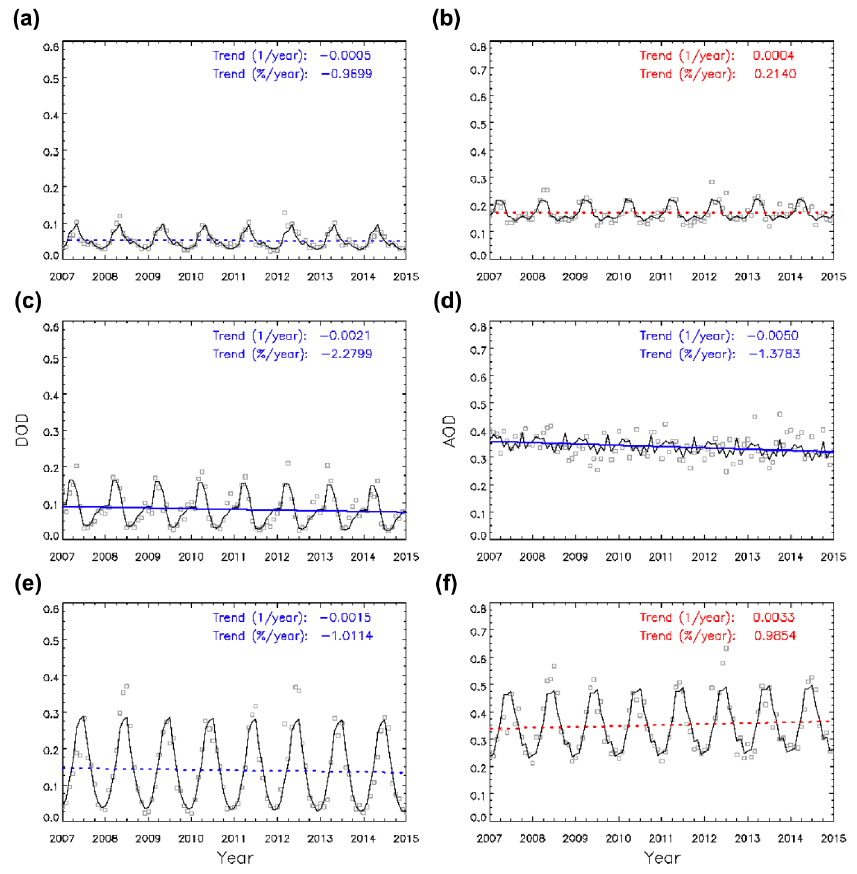
Figure 9. Short-term time series of CALIPSO / CALIOP AOD and D_AOD over South and East Asia (AS), eastern China (EC) and of South Asia (SA) based on observations during the period January 2007–December 2015. The dashed lines show the multi-annual trend line while the continuous black lines depict the seasonal variability. The trends are in units of 1 year − 1 and % year − 1 relative to 2007.